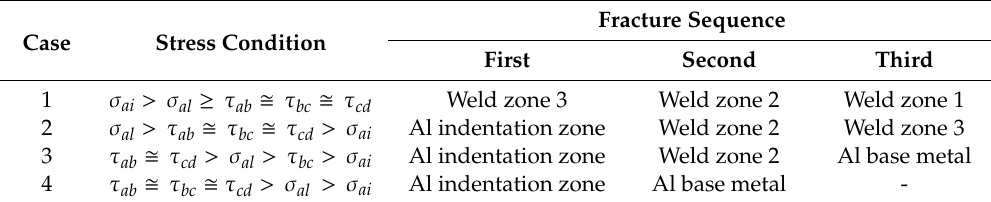
Table 3. Four kinds of fracture